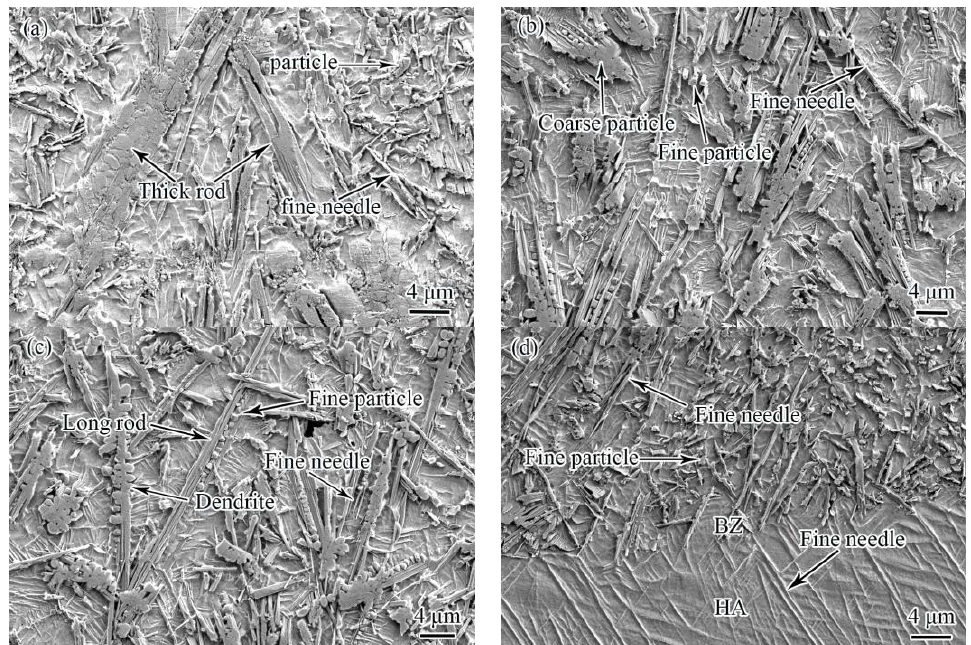
Figure 3. The cross-sectional microstructure of a laser cladding layer with 30%TiB 2 /Ti-based alloy on titanium alloy surface: ( a ) surface layer; ( b ) middle layer; ( c ) bottom layer; ( d ) bonding area. When a pre-set layer utilized TiB 2 and Ti particles with the size of 0.4 µ m–0.6 µ